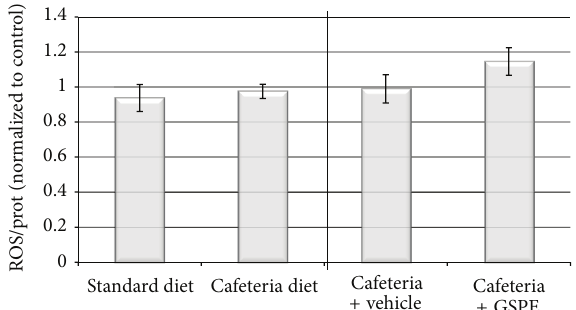
Figure 3: ROS content in the pancreas, expressed as fluorescence arbitrary units/(mg/mL) of protein and normalised to the respective control group. Data are shown as the mean ±